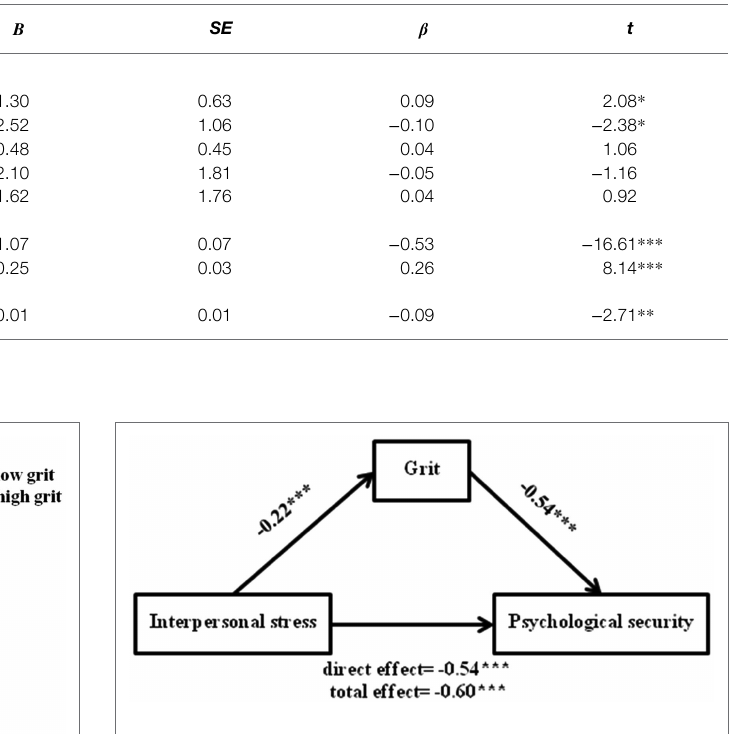
FIGURE 3 | Mediation model of interpersonal stress as a predictor of psychological security mediated by grit. Standardized regression coefficients are displayed for all paths. *** p <